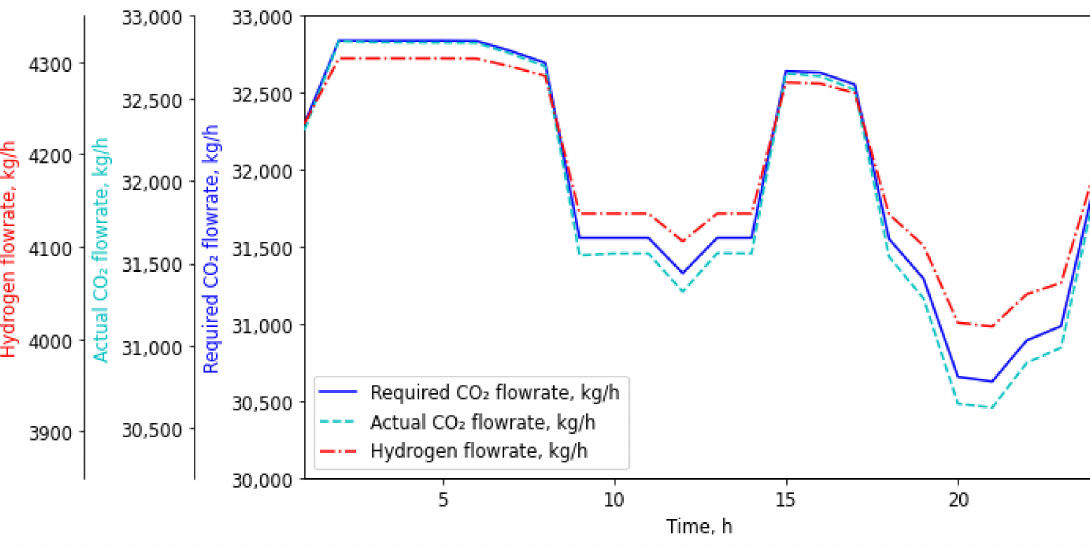
Figure 13. Hydrogen production from the electrolyzer stage and the equivalent CO 2 capture